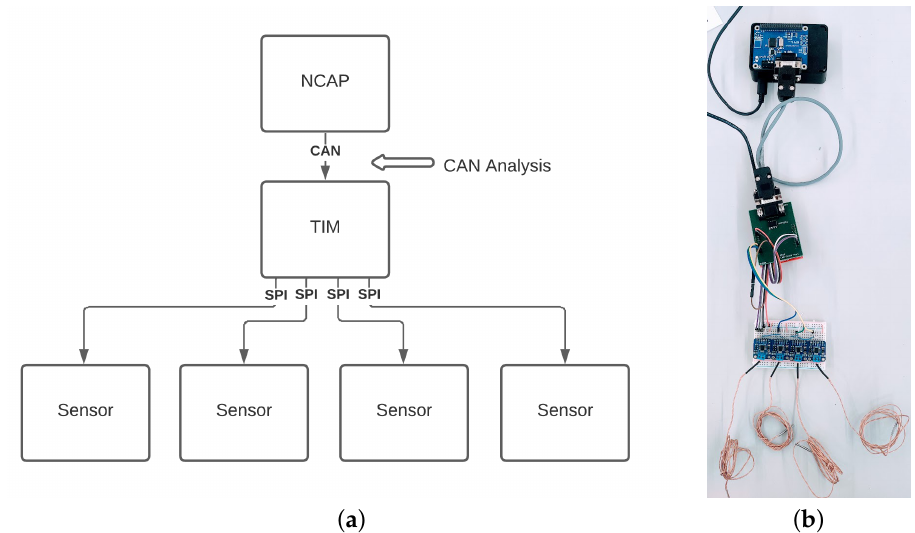
Figure 11. One-to-One-to-Many System: ( a ) Diagram representing one-to-one-to-many system connection; ( b ) Physical representation of the connected one-to-one-to-many system.